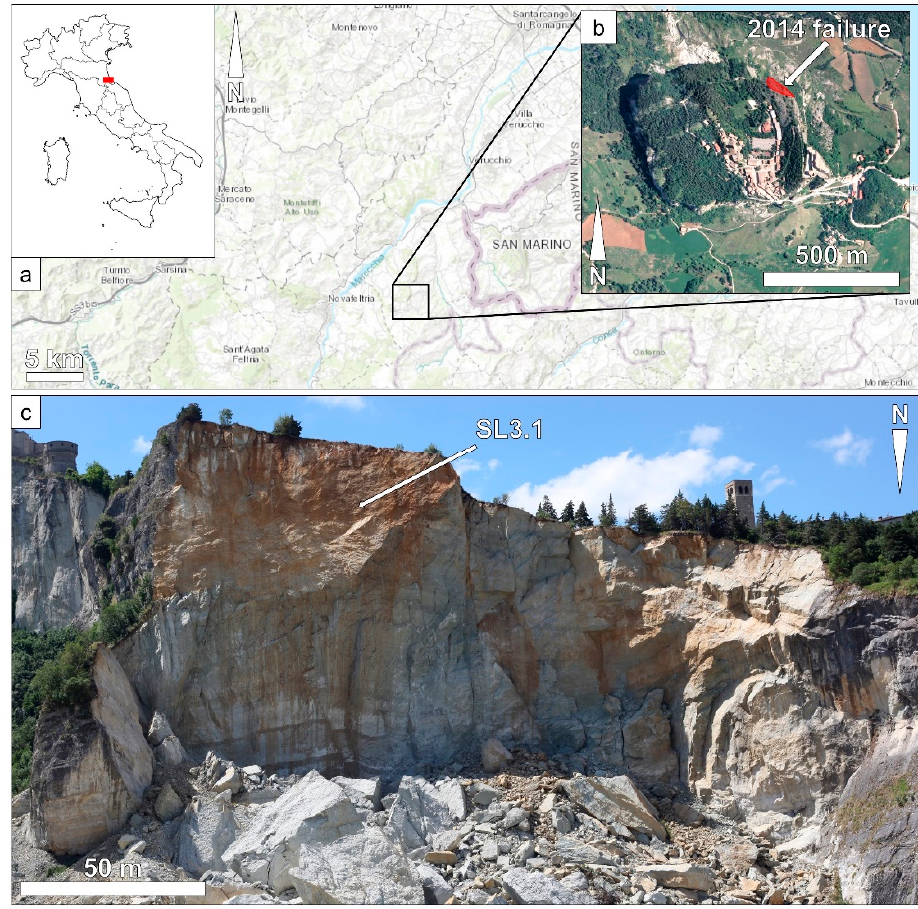
Figure 1. Geographic overview of the investigated slope. ( a ) Location of the San Leo plateau in northern Italy; ( b ) 2011 aerial photograph of the rock slab (courtesy of Emilia-Romagna region). The red polygon highlights the area involved in the 2014 event; ( c ) Oblique view of the rock slope after the failure. Note the iron-oxidized discontinuity SL3.1 (photograph summer 2015).